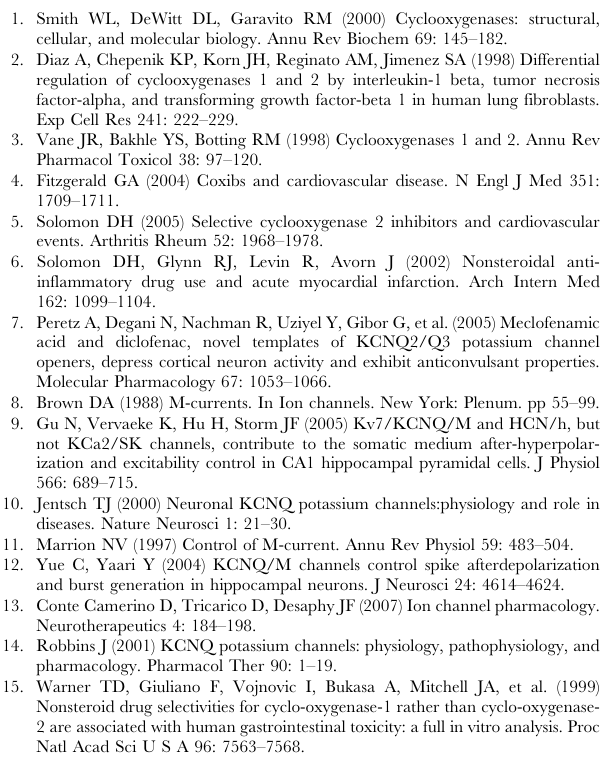
Found at: doi:10.1371/journal.pone.0001332.s001 (0.06